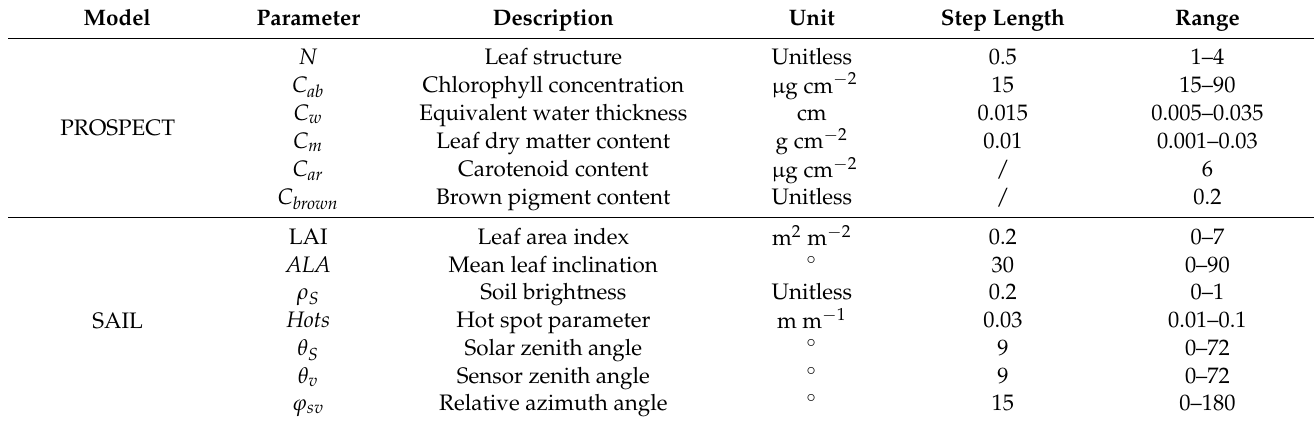
Table 2. Parameter settings of the PROSAIL